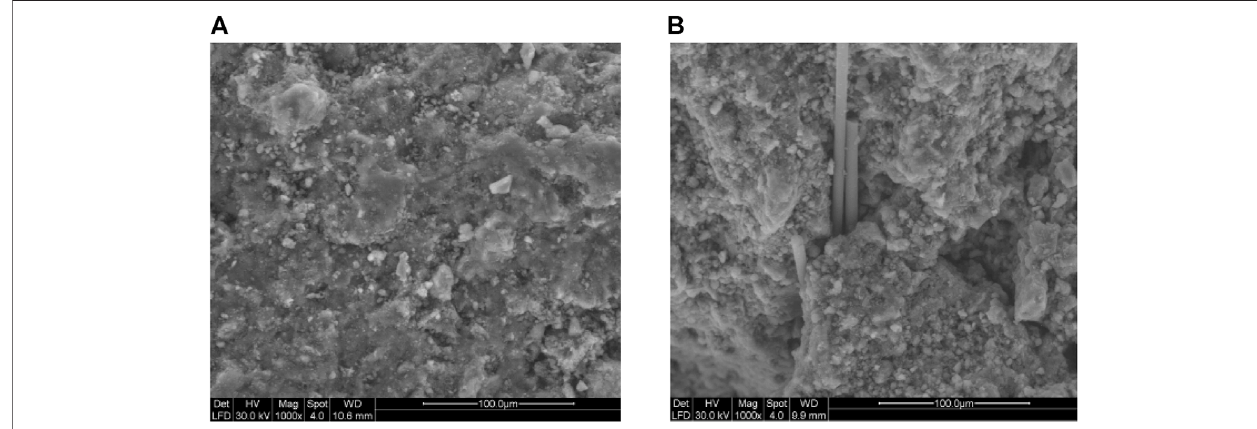
FIGURE 11 | SEM image of high-alumina cement paste with different fi ber content. (A) Fiber content of 0% (B) Fiber content of